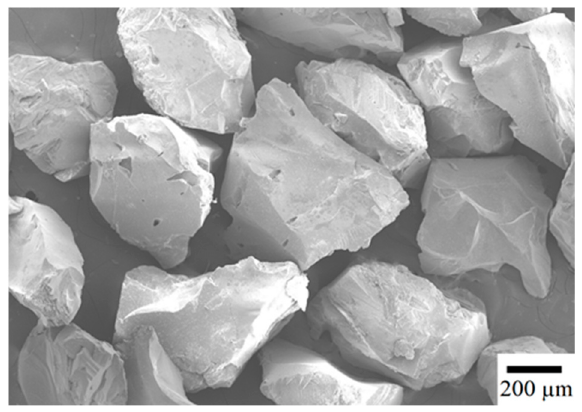
Figure 3. The morphology of the Al 2 O 3 erosion particles.